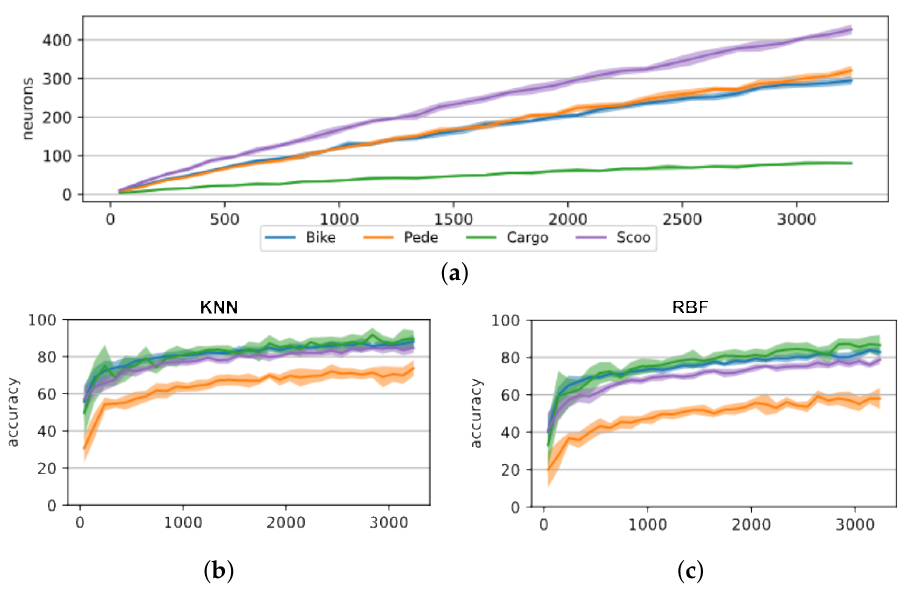
Figure 9. Training behavior of the NM500 with increased number of images in the training dataset, with feature extraction using scaled region of interest of 16 × 16 pixels. ( a ) Neurons committed per class. ( b ) Classification accuracy in KNN mode. ( c ) Classification accuracy in RBF mode.